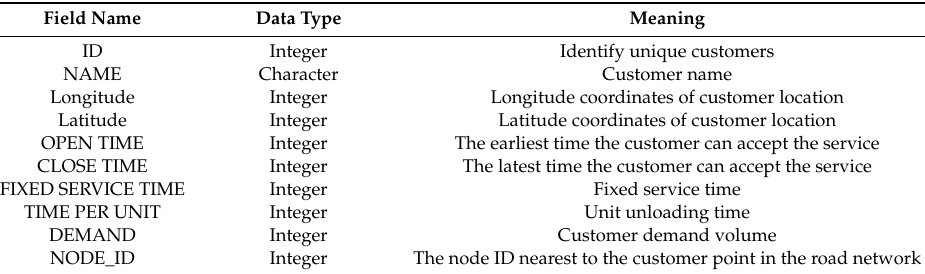
Table 2. Customer point layer data type